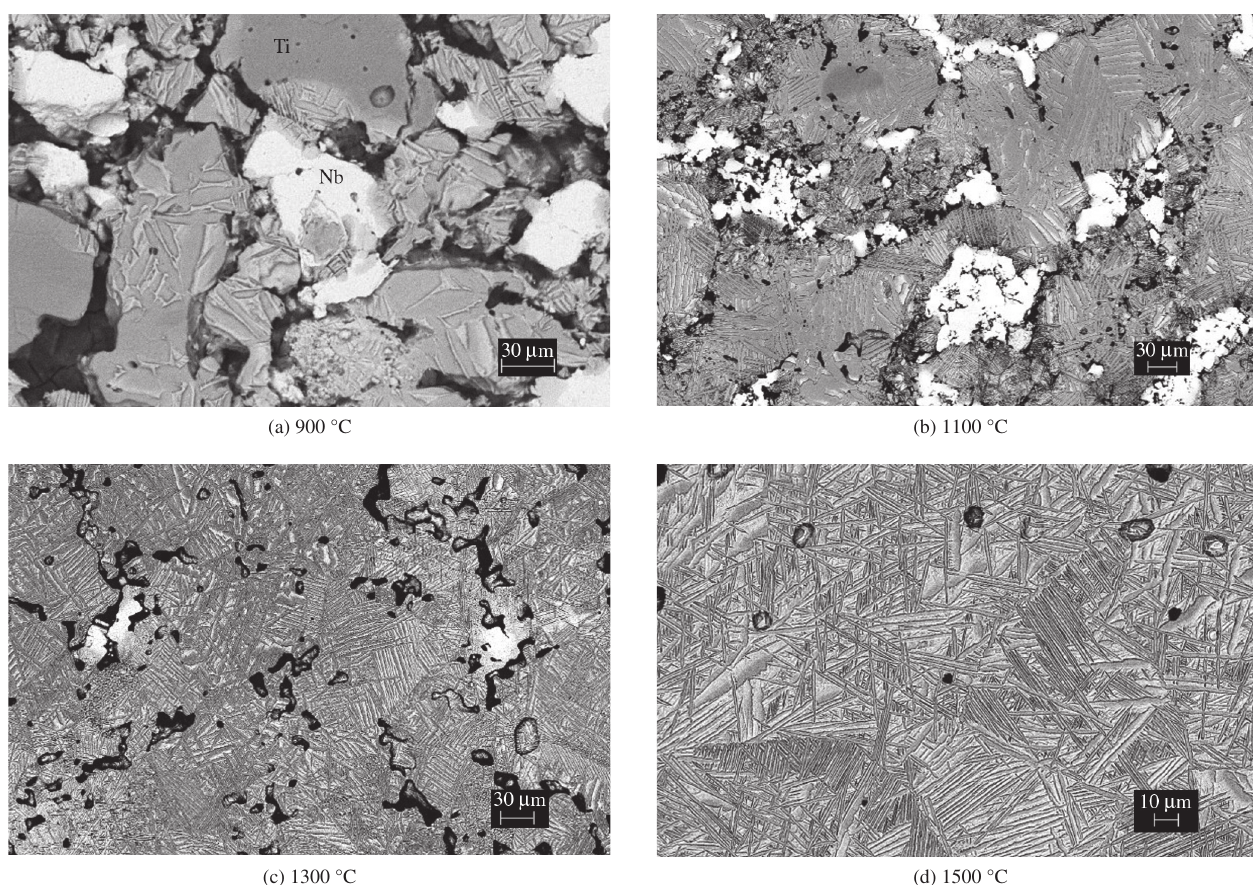
Figure 2. Microstructure of P/M-Ti-13Nb-13Zr alloy with the temperature increase, between 900 to 1500